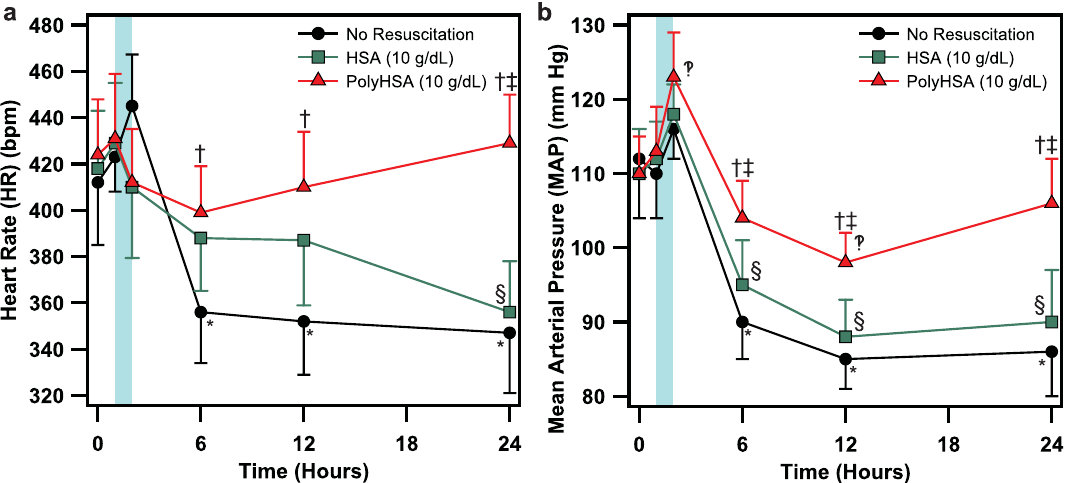
Figure 2. Changes in systemic hemodynamics following LPS induced endotoxemia. ( a ) Heart rate (HR) and ( b ) mean arterial pressure (MAP) with no resuscitation, infusion of HSA, or infusion of PolyHSA. The shaded blue region on the plots indicates the period of fluid resuscitation with PolyHSA or HSA. Data are presented as mean and SD. † P < 0.05 between the PolyHSA and no resuscitation groups at the same time point. ‡ P < 0.05 between the PolyHSA and HSA groups at the same time point. Symbols next to data points indicate a significant (P < 0.05) difference at that time point compared to baseline conditions for (*) no resuscitation, (§) HSA, and ( ‽ ) PolyHSA (n = 6